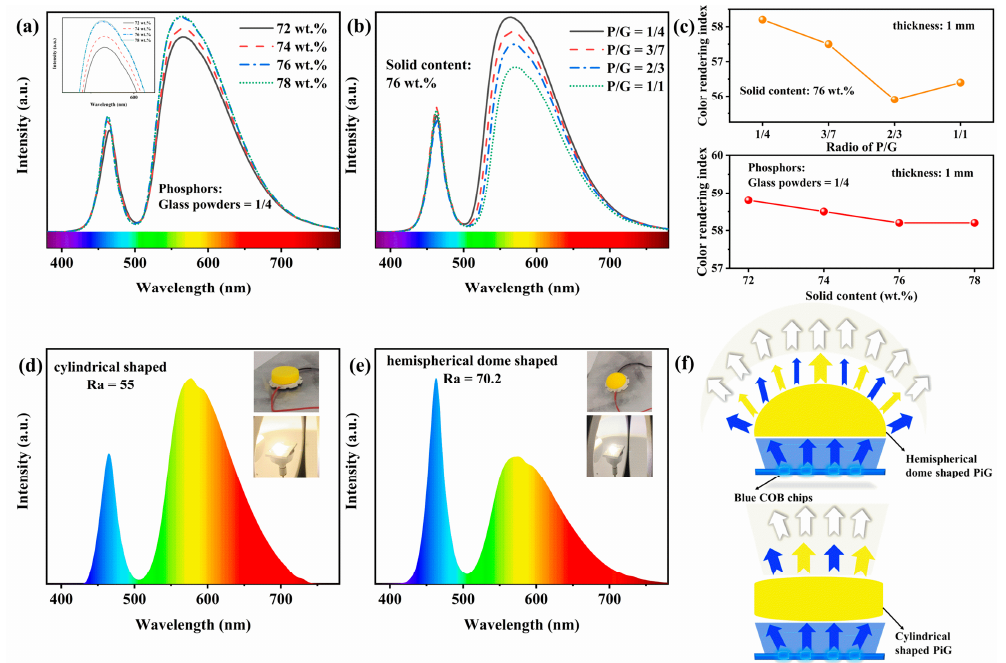
Figure 6. ( a ) The EL spectra of PiGs with different solid contents and ( b ) ratios of phosphors and glass powders; ( c ) Ra of PiGs with the thickness of 1 mm under different solid contents and ratios; ( d , e ) the EL spectra of cylindrical and hemispherical dome-shaped PiGs; ( f ) schematic diagram of cylindrical and hemispherical dome-shaped PiGs lit by blue COB chips.